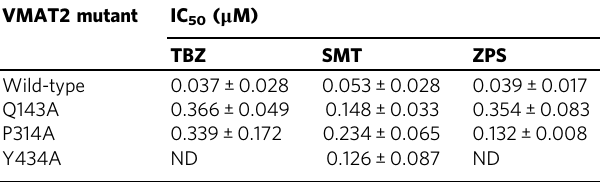
ND not determined due to lack of inhibition within the range of tested concentrations (0 – 10 μ M). VMAT2 mutants F136A, F136A-F335A, V233A-L234A, F335A, and F335A-L336A were tested in this assay but did not have suf fi cient activity or inhibition to determine a reliable IC 50